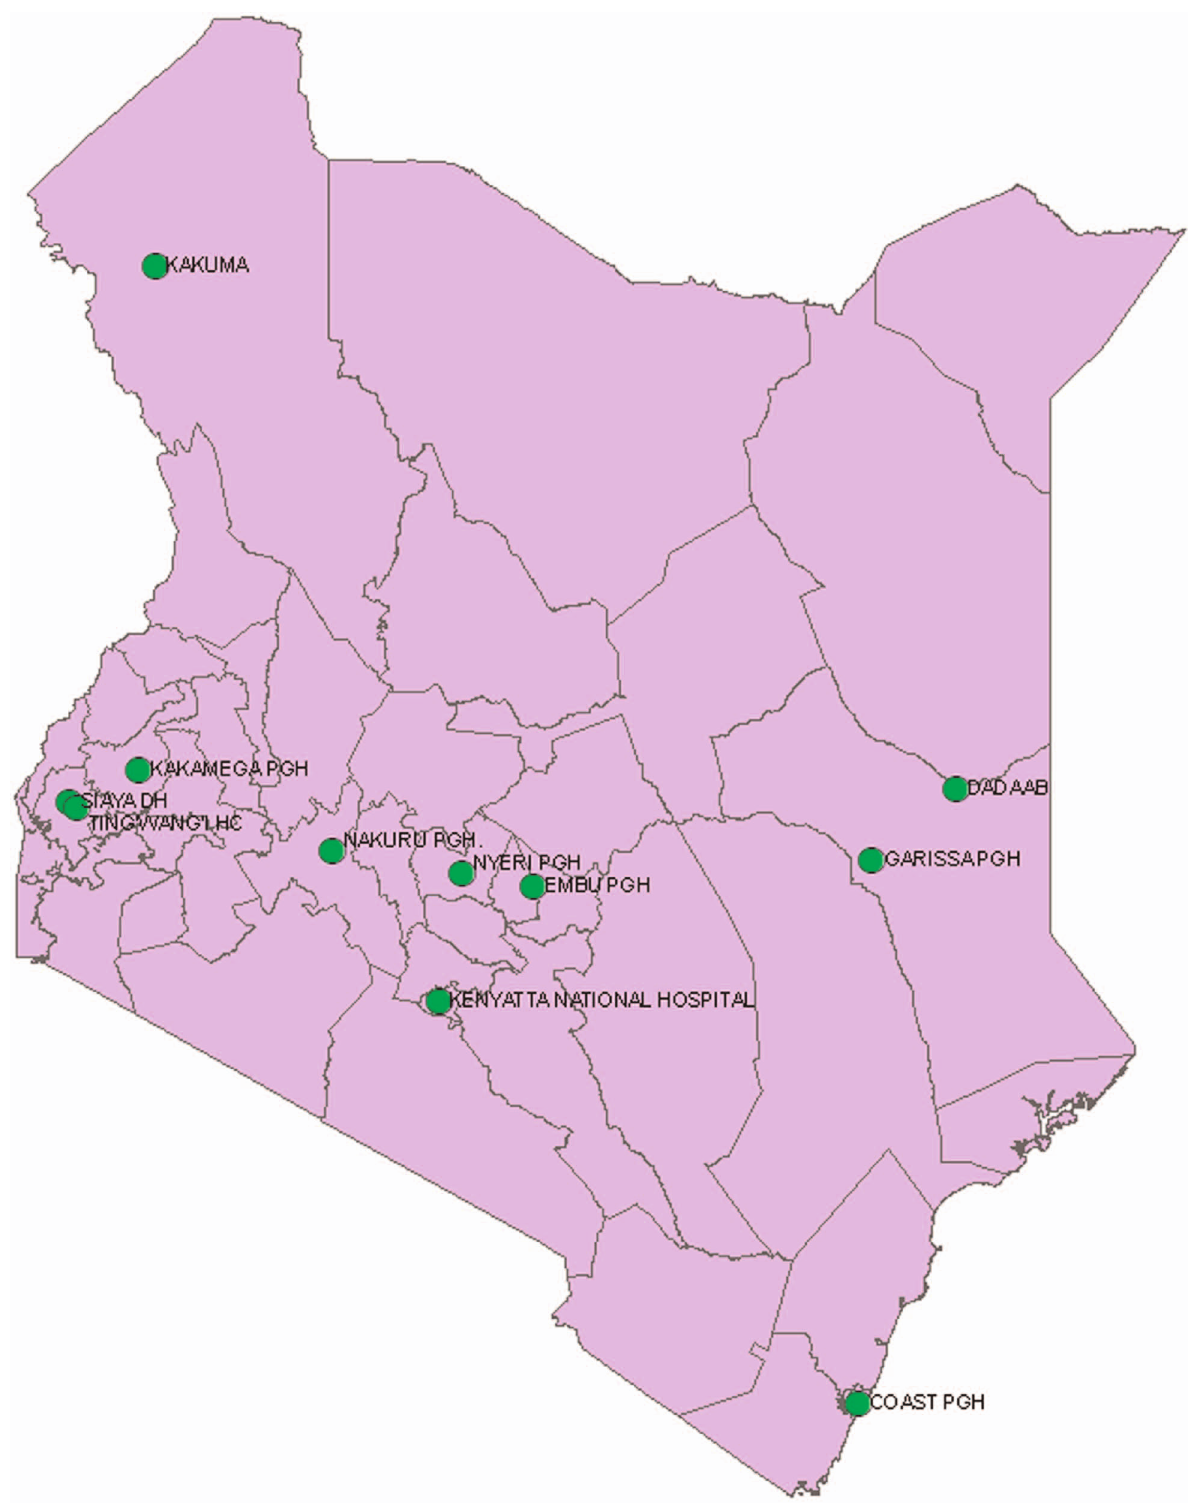
Figure 1. Map of Kenya showing the distribution of influenza sentinel surveillance site.